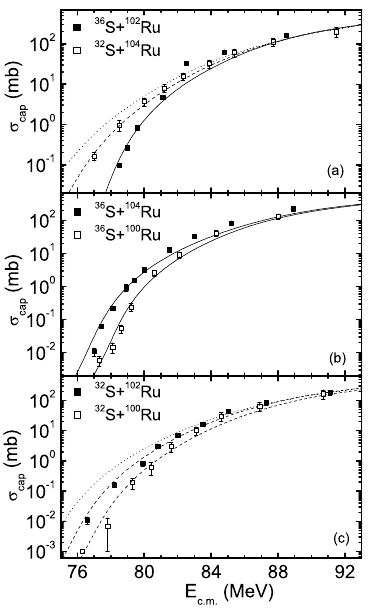
Figure 9. The calculated capture cross sections vs E c . m . for the reactions 32 S + 100 , 102 , 104 Ru (dashed lines) (a,b,c) and 36 S + 100 , 102 , 104 Ru (solid lines) (a,b). The dotted lines correspond to the reactions 32 S + 102 , 104 Ru (a,c) when the neutron transfer is disregarded. The experimental data (symbols) are from Ref. [18].